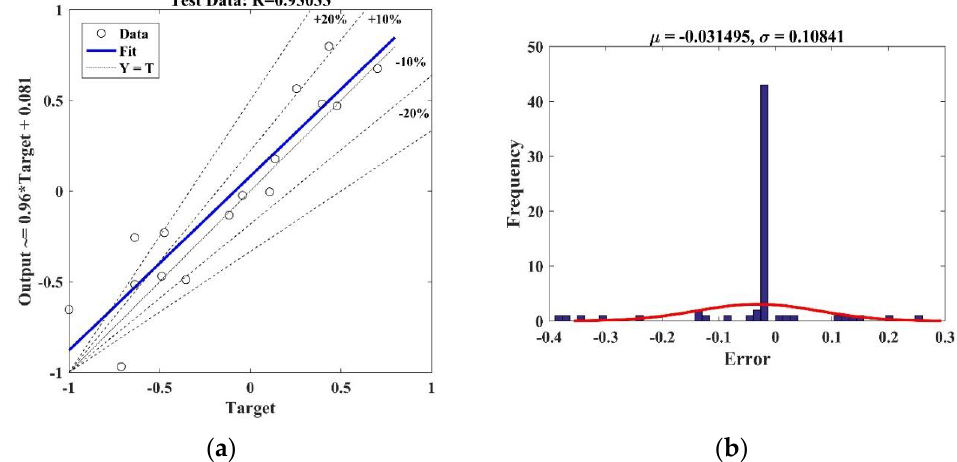
Figure 5. EM prediction precision and error histogram using SVR: ( a ) correlation coefficient and ( b ) error histogram.